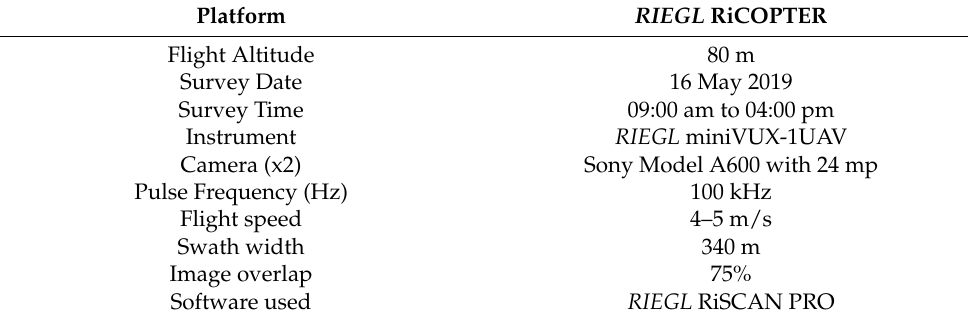
Table 2. UAV LIDAR Flight